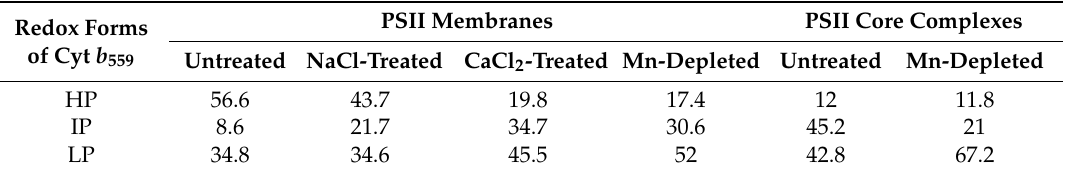
Table 1. The ratio of Cyt b 559 redox forms in PSII preparations after various modifications of the water-oxidizing